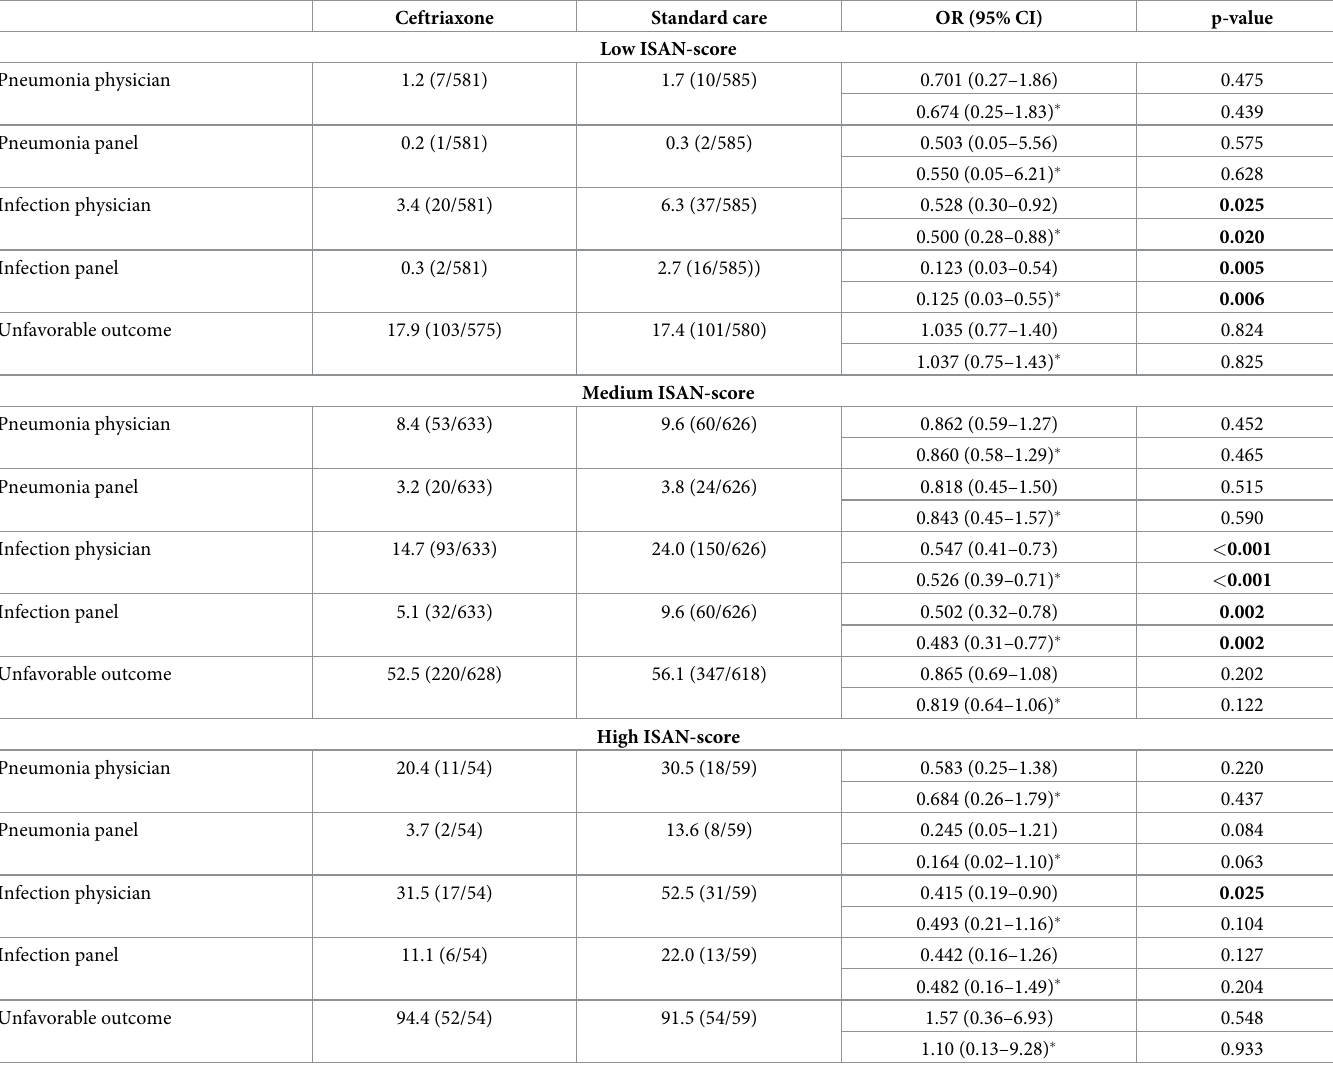
Table 3. Univariate and multivariate analysis of outcomes per ISAN score